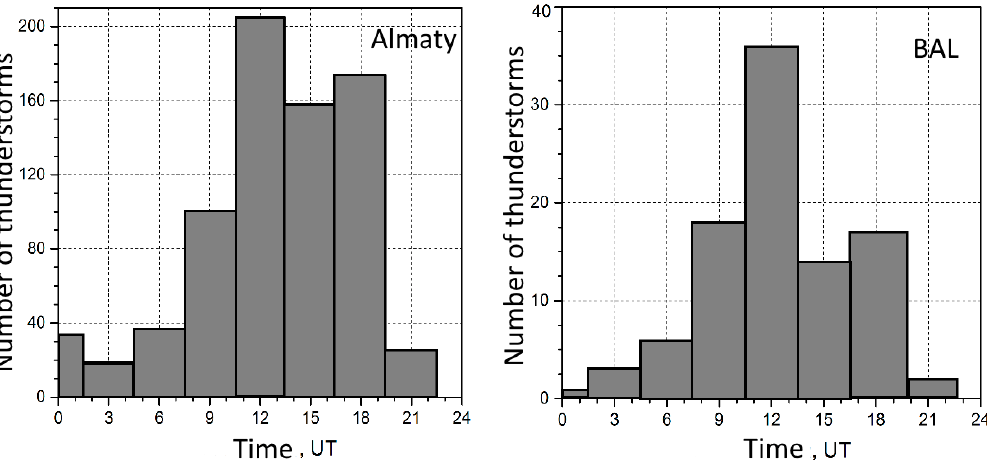
Figure 4. Diurnal distribution of thunderstorms at the Almaty meteorological station and the Big Almaty Lake (BAL) meteorological station.